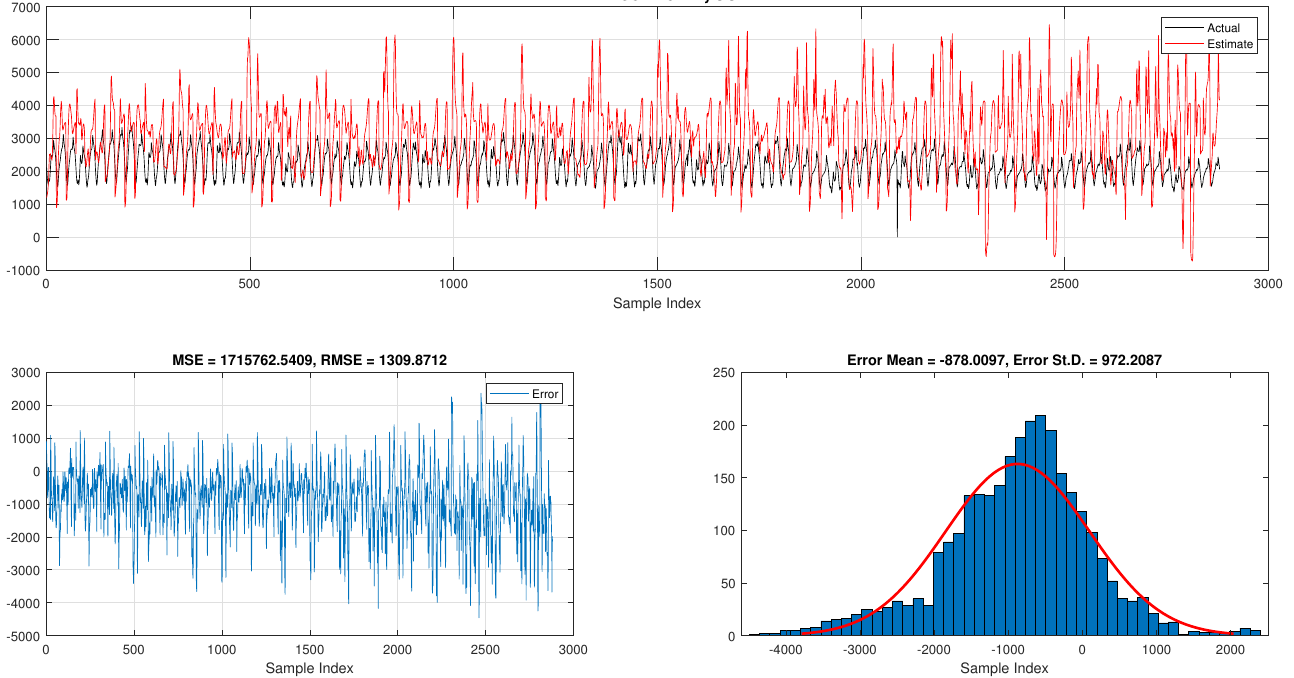
Figure 12. Error analysis of the hourly daily load consumption with fNN-ACO best